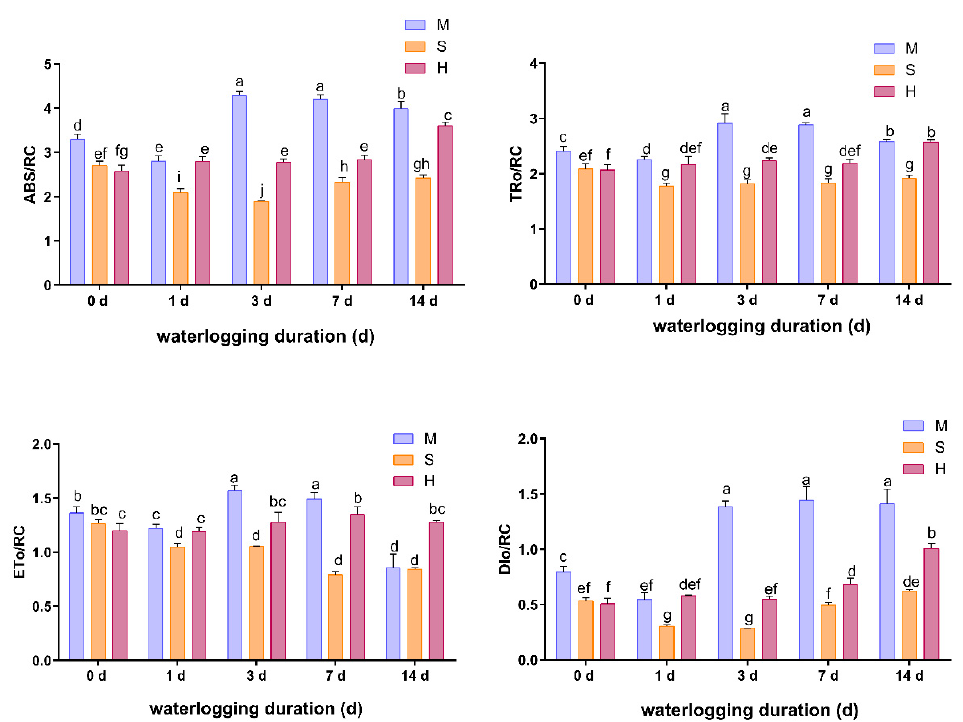
Figure 5. Absorption, transformation and usage of light energy in leaf light reaction center of different peach rootstock seedlings under waterlogging stress. Abbreviations: M: Prunus persica, ‘Maotao’; S: Prunus davidiana, ‘Shantao’; H: ‘Hossu’. The data are the means ± SDs. Within columns, means with a different letter indicate significant differences ( p < 0.05) using Duncan’s test; bars on the columns represent the standard errors (SD) (n = 6).